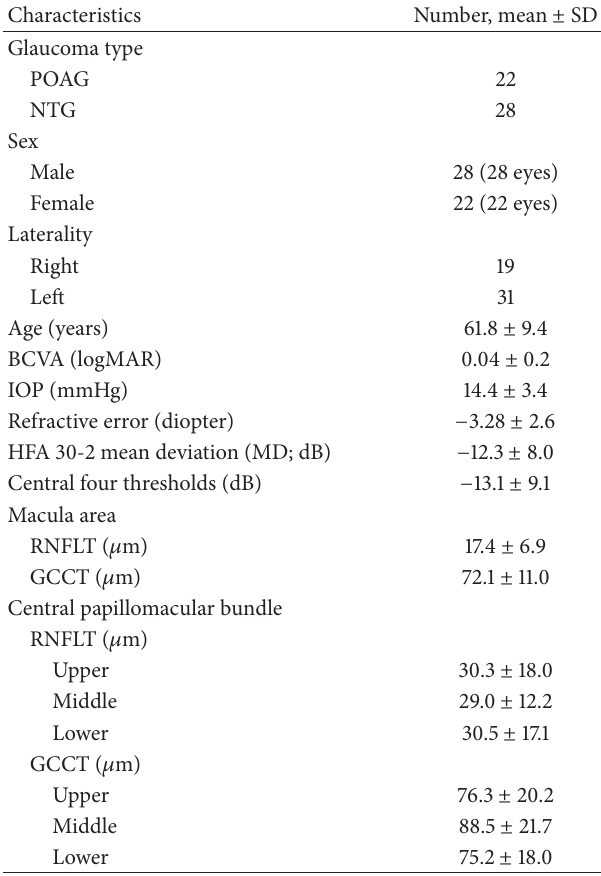
Table 1: Characteristics of